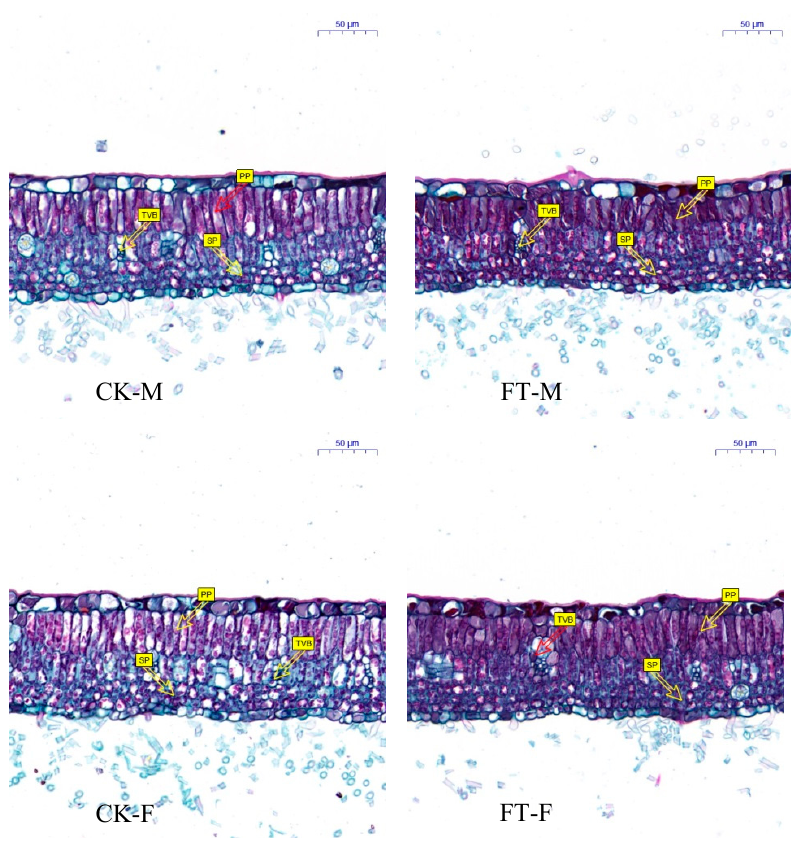
Figure 3. Leaf cross-sections of male vs. female Salix viminalis plants at 45 days of flooding treatment. Observations were done using th NIKON ECLIPSE E100 microscope at 20 × Magnification. Scale bars = 50 µ m. PP, palisade parenchyma; SP, spongy parenchyma; TVB, transcurrent vascular bundle.